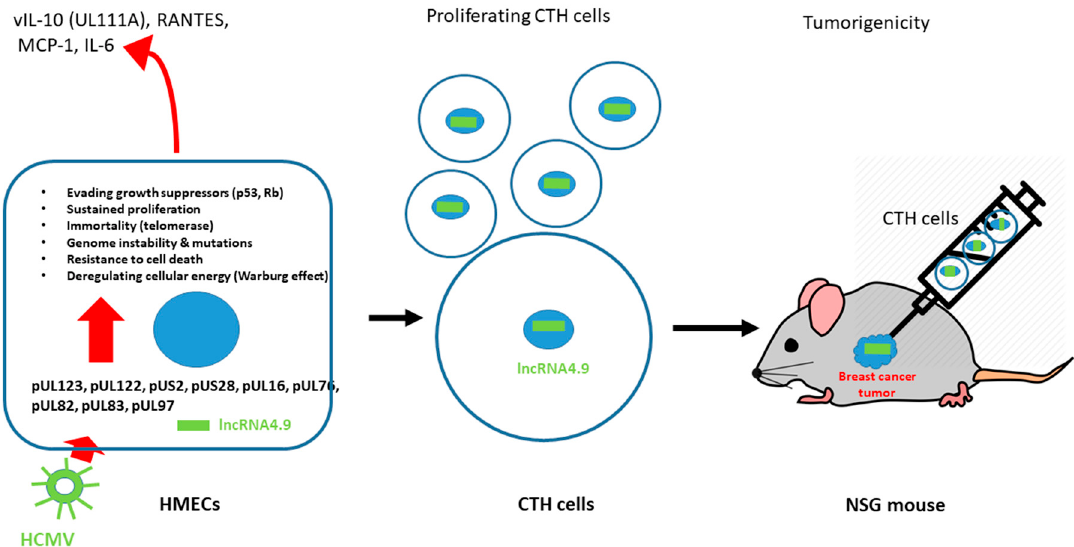
Figure 3. A model for HCMV oncogenesis: from viral proteins activating oncogenic pathways in infected HMECs to tumor growth in xenografted NOD/SCID Gamma (NSG) mice. CTH—CMV-transformed HMEC.